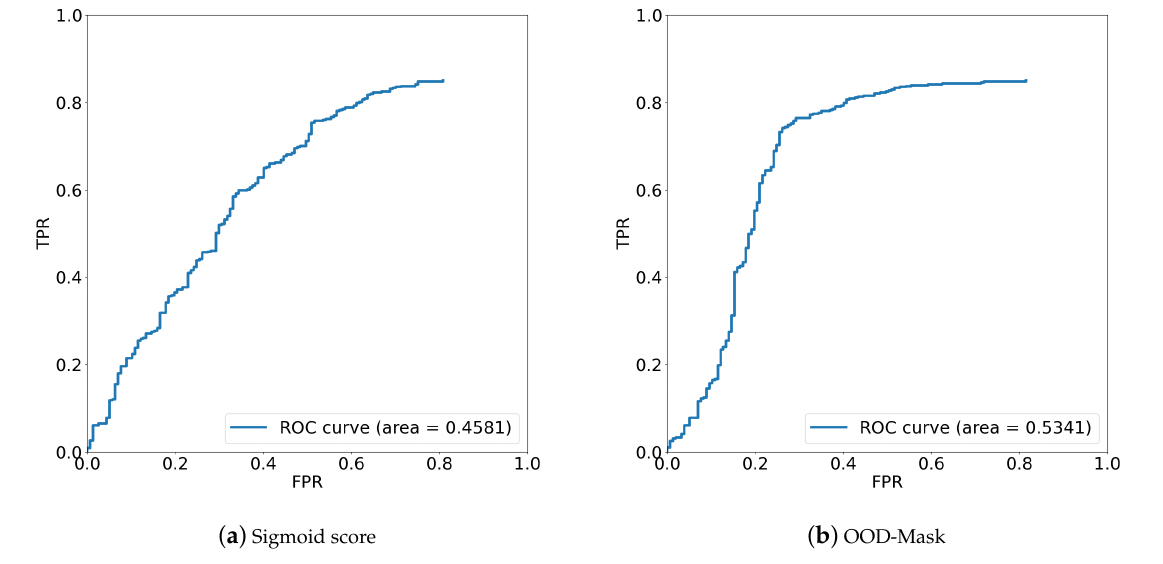
Figure 9. ROC under different